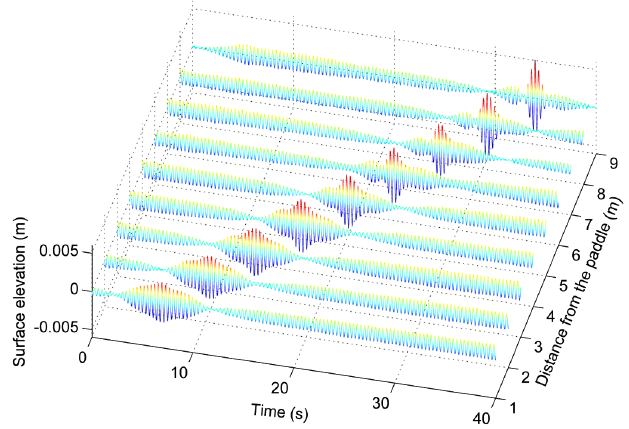
FIG. 4. Final stage of the evolution of the temporal profile of the water-surface elevation along the wave tank demonstrating the super-RW formation at X ¼ 9 (in total 72 m).